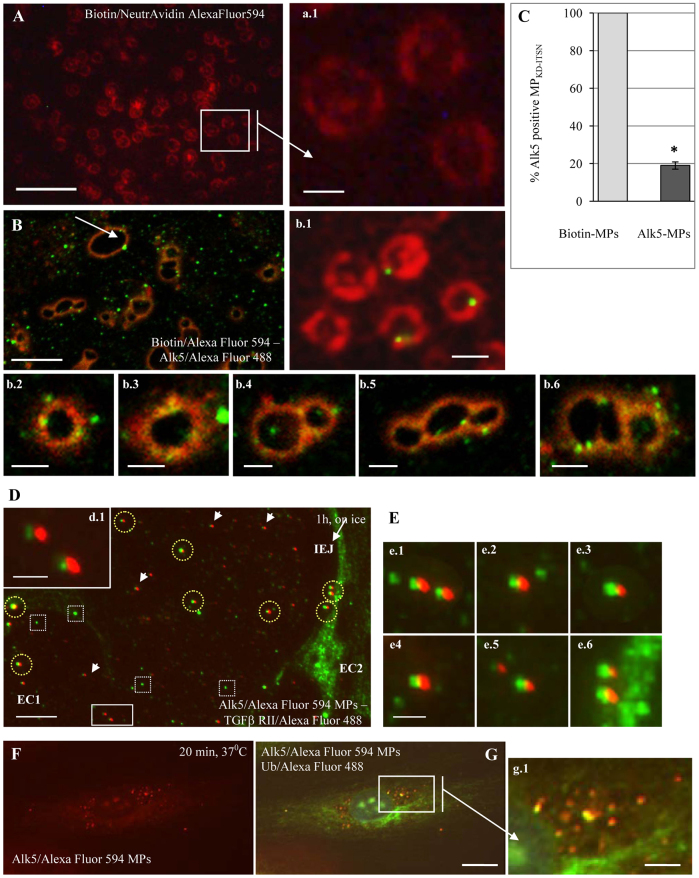

MPKD-ITSN transfer Alk5 to ECKD-ITSN.MPKD-ITSN transfer Alk5 to ECKD-ITSN. (A,a1) Biotin and neutrAvidin–Alexa-Fluor-594 labeling of MPKD-ITSN reveals multiple donut-shaped particles. Double labeling of Alk5 (Alexa Fluor 488) along with biotin and neutrAvidin–Alexa Fluor-594 labeling revealed Alk5 clusters associated with the donut-shaped microparticles (B,b.1–b.6). Light microscopy (b.1) and confocal images (b.2–b.6) illustrate Alk5 immunoreactivity associated with microparticles and the capability of microparticles to fuse with each other (B, arrow; b.4–b.6); the arrow in B indicates a 3–4 µm diameter particle, most likely generated by fusion of individual microparticles due to the relatively long time of processing before 1% paraformaldehyde fixation. (C) Morphometric analyses of Alk5-positive MPKD-ITSN. Data are shown as a percentage relative to the control and show the mean±s.e.m.; *P<0.05; n = 3. (D) ECKD-ITSN exposed to anti-Alk5–Alexa-Fluor-594 pre-labeled microparticles (MPs) on ice for 1 h were co-stained with anti-TGFβ-RII and an Alexa-Fluor-488-conjugated secondary. Frequent colocalization is suggestive of their heterodimerization and residence on the same microparticle (yellow circles). The endogenous TGFβ-RII is not always associated with microparticle-derived Alk5 (white squares). Even when colocalization of Alk5 and TGFβ–RII is not obvious, Alk5 and TGFβ-RII immunoreactive puncta are found in very close proximity (arrowheads and inset d.1). The arrow in D indicates an interendothelial junction (IEJ). (E,e.1–e.6). Gallery of highly magnified Alk5–TGFβ-RII heterodimers. (F,G) At 37°C, the microparticle-derived Alk5 is detected inside endothelial cells that were counterstained for ubiquitin (Alexa Fluor 488). Scale bars: 10 µm (A,D), 5 µm (B), 1.2 µm (d.1,E), 20 µm (F,G), 1 µm (b.2,b.4,b.5,b.6), 0.5 µm (a.1,b.1,b.3), 4 µm (g.1).